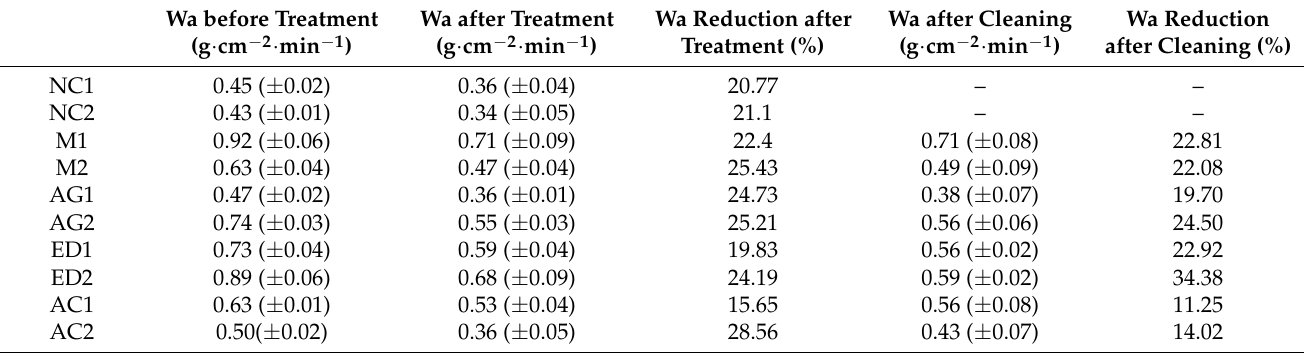
Mean values determined 3 WAC measurements per each sample. Wa after treatment (%) corresponds to the difference in WAC between before and after the consolidation treatment. Wa after cleaning (%) corresponds to the reduction in WAC between before and after cleaning with respect to the values of the consolidation treatment. Standard deviation in parenthesis. Percentage decrease was calculated by the formula: % Decrease ( ∆ W) = Decrease (W final − W initial)/Original Number (W initial) ×